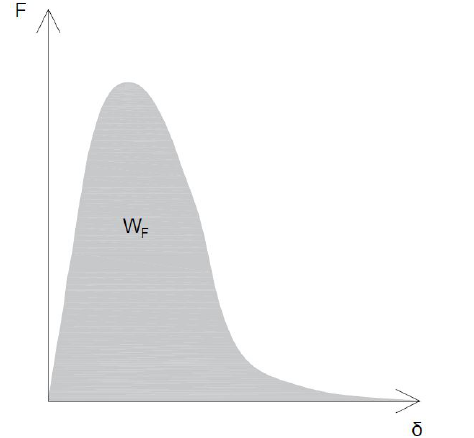
Figure 8. Fracture energy of tested